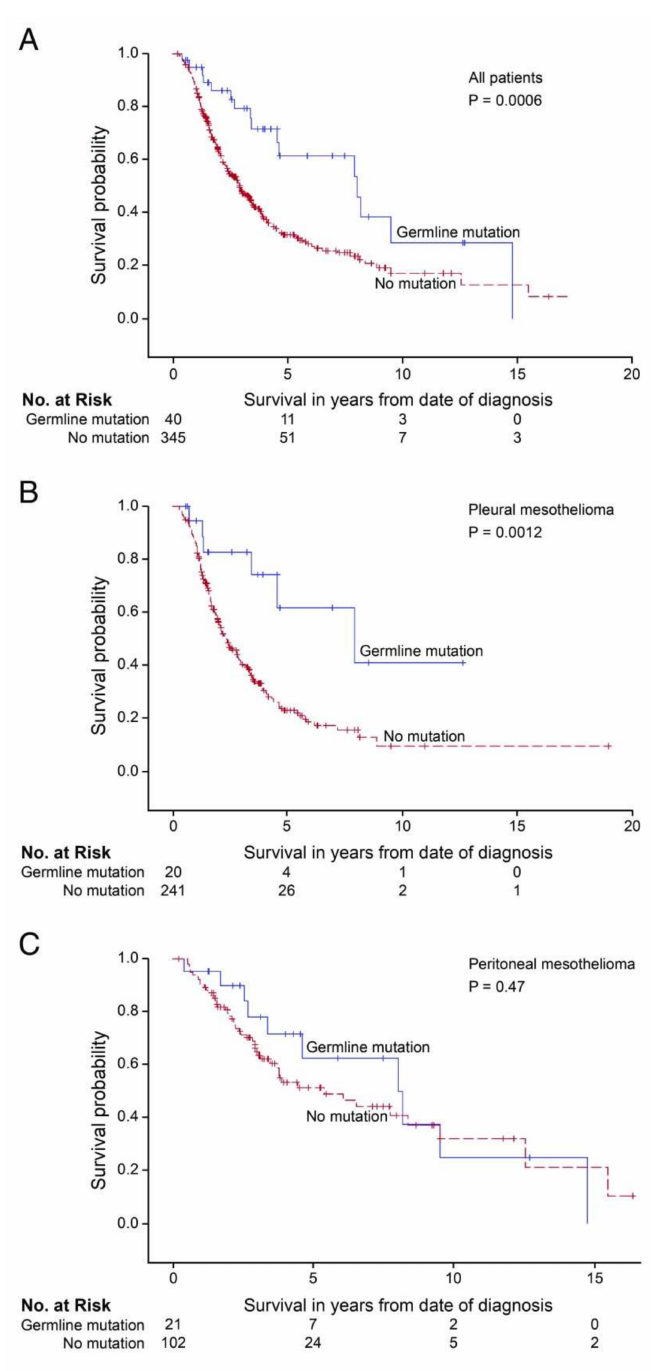
Figure 3. Survival of patients with mesothelioma treated with platinum-based chemotherapy, by patient’s genotype and primary site of tumor. Survival of patients with an inherited damaging mutation in any targeted gene is indicated in blue; survival of patients with no inherited mutation is indicated in red. ( A ) All mesothelioma patients with versus without inherited mutations. Median survival: 8.0 vs. 2.9 y, p = 0.0006. ( B ) Pleural mesothelioma patients with versus without inherited mutations. Median survival: 7.9 vs. 2.4 y, p = 0.0012. ( C ) Peritoneal mesothelioma patients with versus without inherited mutation. Median survival: 8.2 vs. 5.4 y, p = 0.47. Reprinted with permission from Proceedings of